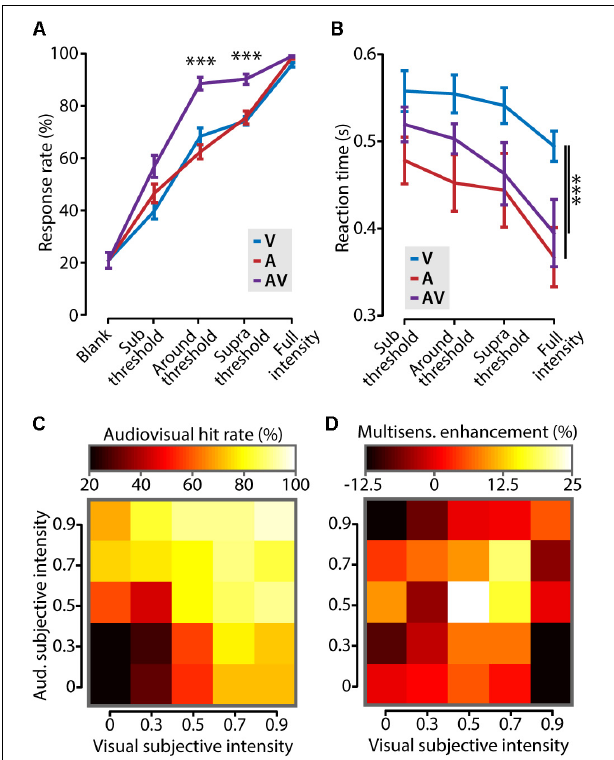
FIGURE 3 | Cross-modal increase of stimulus detection performance. (A) Mice showed a significantly higher response rate (i.e., number of correctly detected stimuli as percentage of the total) in the audiovisual (AV) condition compared to the visual (V) and auditory (A) conditions when stimulus intensities were around and above (supra) threshold (one-way ANOVA with post hoc Tukey–Kramer; ∗∗∗ p < 0.001). (B) Reaction times were shorter for stimuli that contained a tone (A and AV) compared to the visual-only condition (V, two-way ANOVA with post hoc Tukey–Kramer; ∗∗∗ p < 0.001). (C) The performance on audiovisual trials for all different combinations of binned visual and auditory subjective intensity is color coded in a heat map. Subjective intensity is defined as the hit rate that a certain stimulus intensity elicits. The leftmost column and bottom row show the unisensory hit rates. (D) The increase in behavioral performance for all combinations of subjective intensities shows that cross-modal enhancement of behavior is strongest when both unisensory stimuli are presented at threshold intensity (subjective intensity ≈